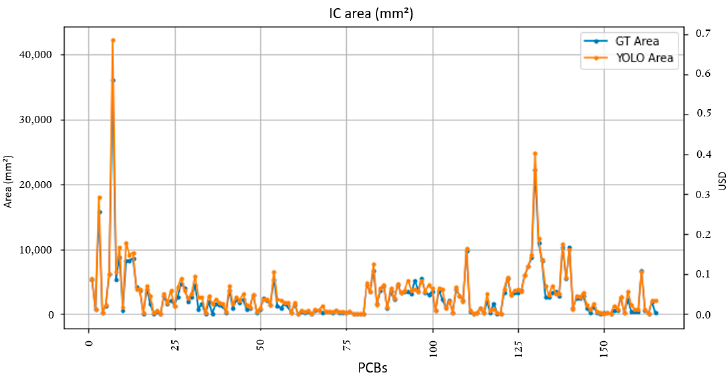
Figure 7. Comparison of IC area ( 𝑚𝑚2 ) calculated and real for each PCB.